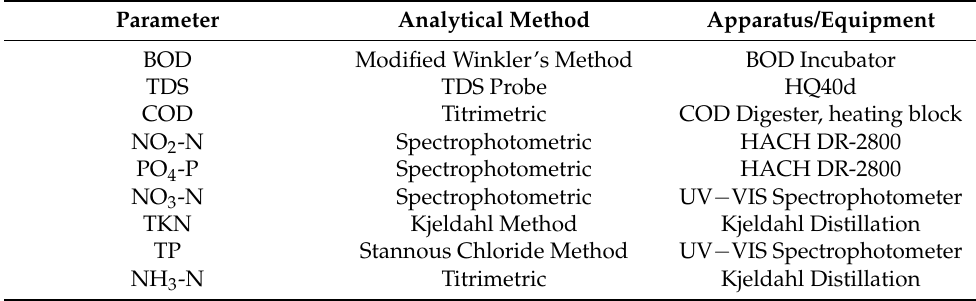
Table 1. Analytical methods used for the analysis of water quality